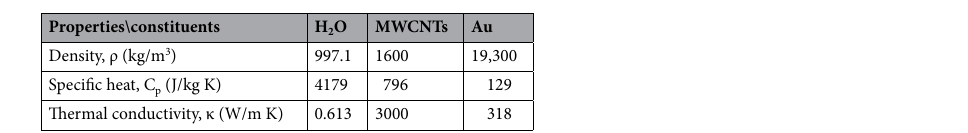
Table 2. Experimental values of thermal features of nanomaterials and base fluid at 25